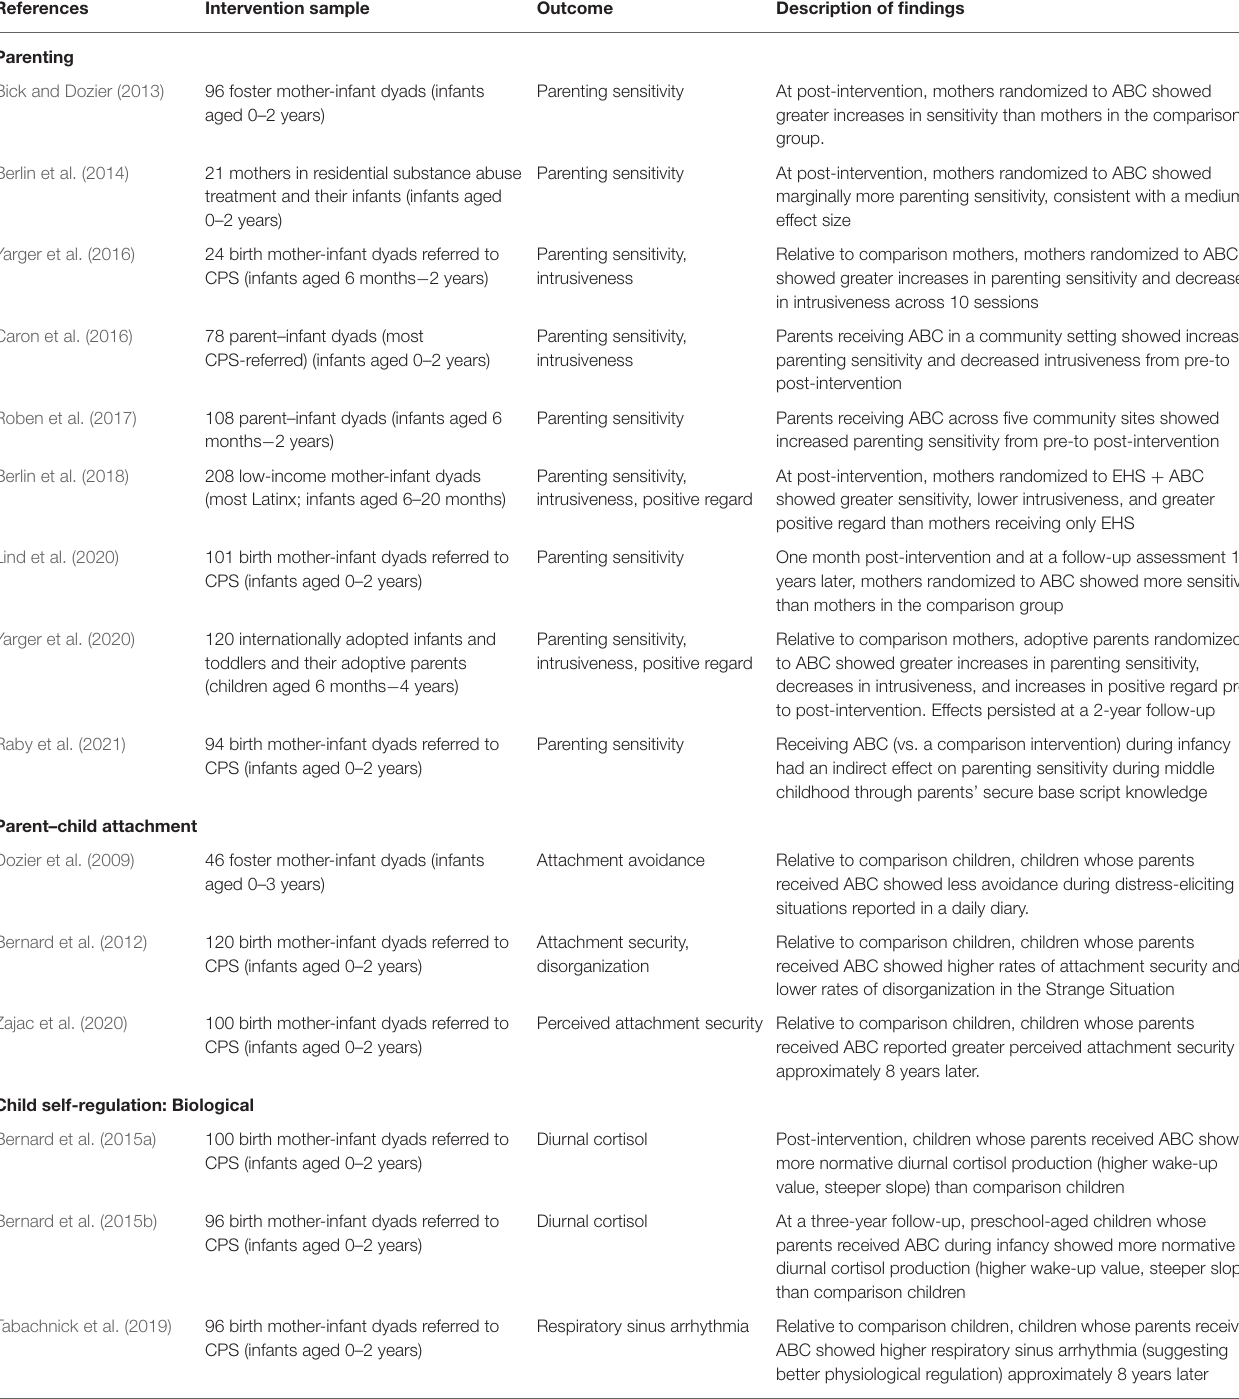
TABLE 2 | Review of ABC effects on parenting, parent–child attachment, and child